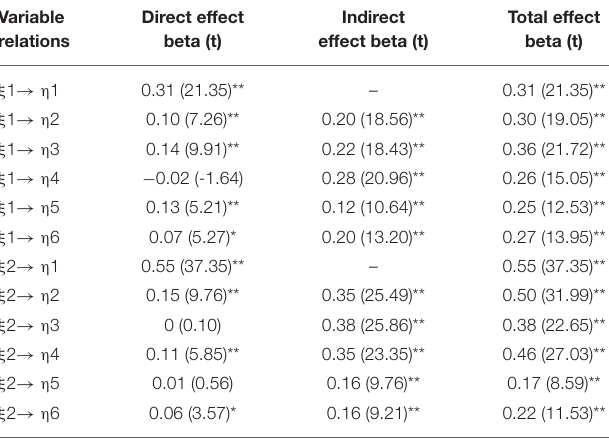
TABLE 3 | Path analysis.